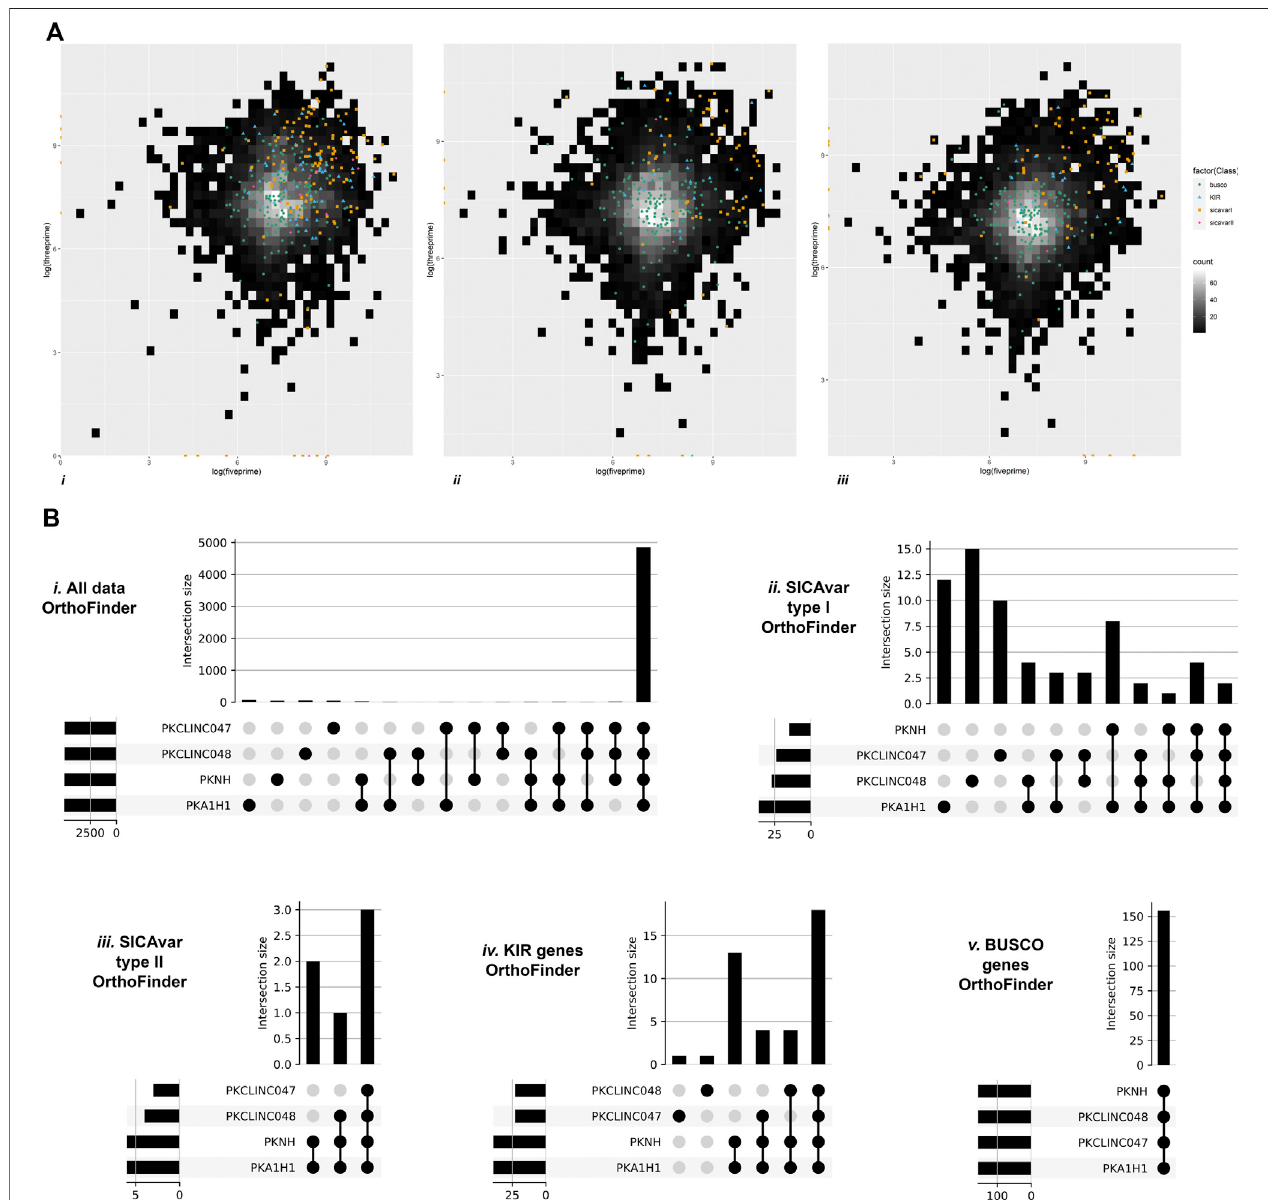
FIGURE 5 | Genomic organization of multiple gene family members. Figure 5A Heatmap gene density plots showing 5 ’ against 3 ’ intergenic distances (log10) for the draft genomes. (i) StAPkA1H1 experimental cultured line, (ii) clinical isolate sk047, and (iii) clinical isolate sk048. Gene density for intergenic distances is represented by color scale ranging from black (low) to white(high, maximum of 60 genes per bin). Genes classed as BUSCO (green dots), SICAvar type 1 (orange squares), SICAvar type 2 (pink diamond), and kir (blue triangles) are shown. SICAvar type 1 and kir genes had a signi fi cantly greater distance to their neighboring genes than the BUSCO genes(Wilcoxon signed-rank test, Bonferroni p -value adjustment, p= < 1e-09), suggesting thatthese gene family membersare ingene-sparseregions. Genes situated at the start or end of scaffolds were excluded from the analysis. Figure 5B OrthoFinder gene cluster outputs were visualized using “ UpSets ” to determine the membership of genes between clusters in the PKNH reference genome (Pain et al., 2008) and the draft genomes; StAPkA1H1 experimental cultured line, clinical isolate sk047,andclinicalisolatesk048.Allgeneclusters(i), SICAvar type1geneclusters(ii), SICAvar type2geneclusters(iii), kir geneclusters(iv),and BUSCO geneclusters(v) are shown. The majority of all gene clusters were present in all isolates with the exception of SICAvar type 1 gene clusters with 10 – 15 SICAvar type 1 clusters being unique per isolate. For kir genes, the majority of clusters were shared between all isolates with the exception of a single unique kir gene cluster in each of sk047 and sk048. The majority of SICAvar type 2 genes were orthologues between all isolates with some not identi fi ed in sk047 and sk048.